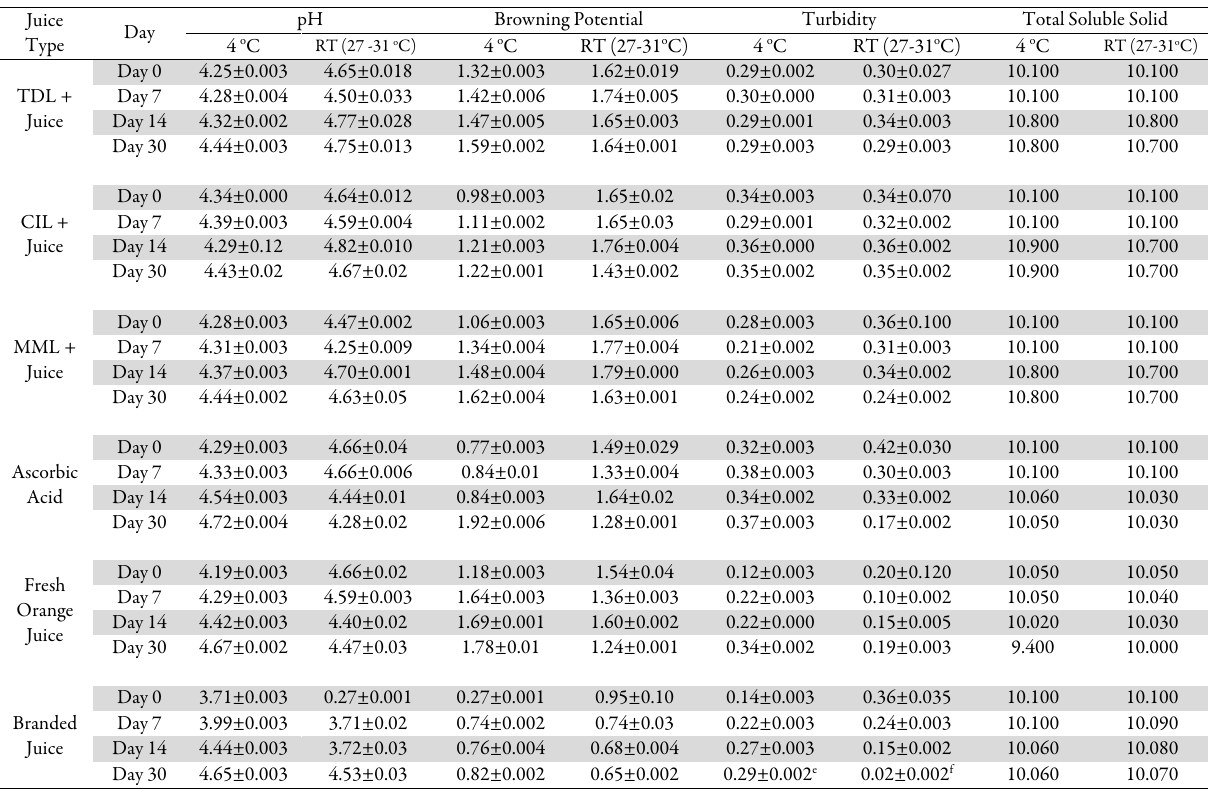
Table 1. Quality parameters of stored fresh orange juice for 30 days Juice Type